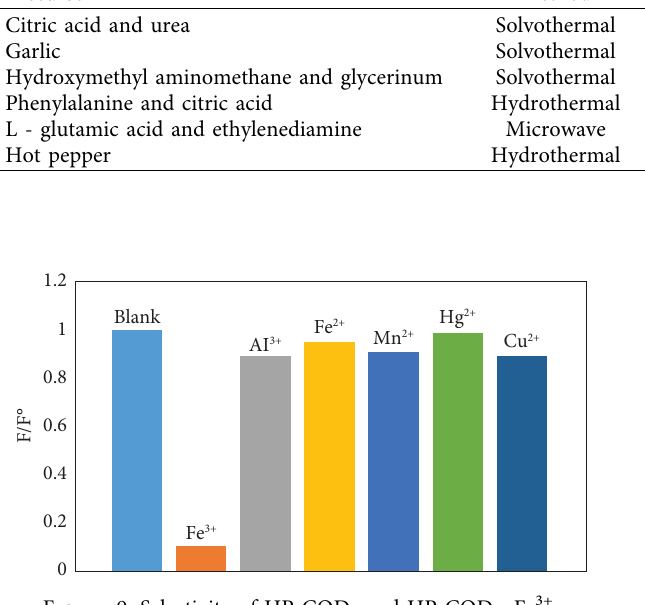
Figure 9: Selectivity of HP-CQDs and HP-CQDs: Fe 3+ .